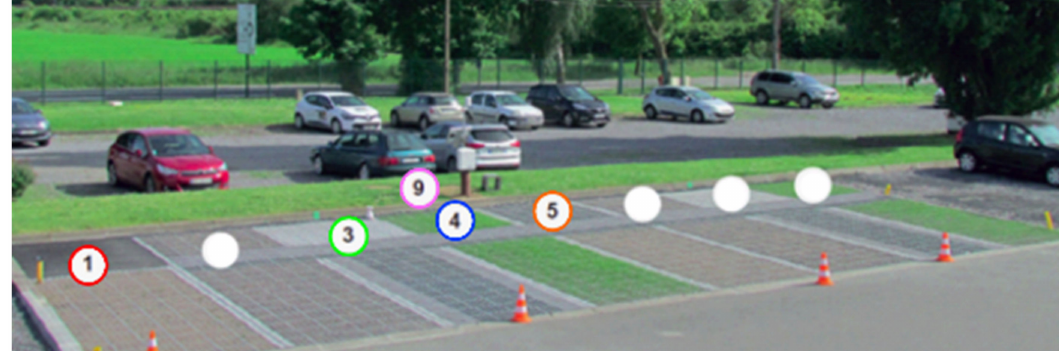
Figure 2. View of the experimental site. Studied parking lots are 1 (red round), 3 (green round), 4 (blue round), 5 (orange round), and control zone 9 (pink round). The other parking lots were not considered due to experimental issues.